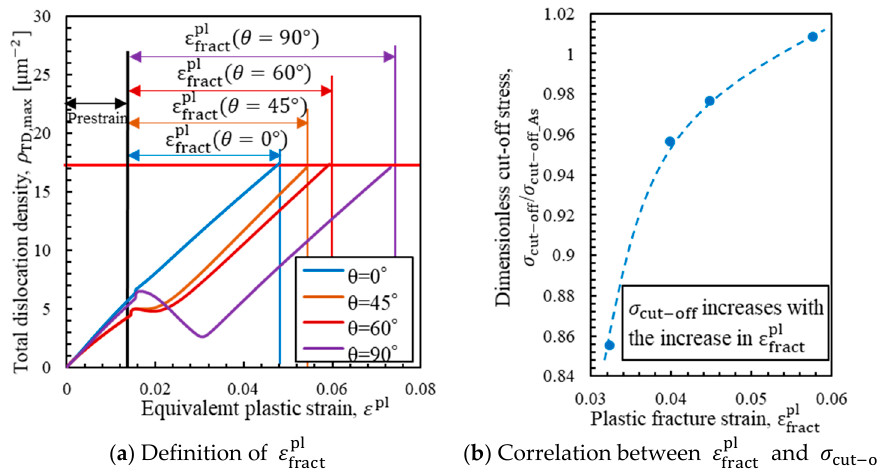
Figure 9. Mechanism of change in σ cut − o ff during loading with di ff erent prestrain directions. ( a ) Definition of ε pl , ( b ) Correlation between ε pl and σ cut − o ff fract fract